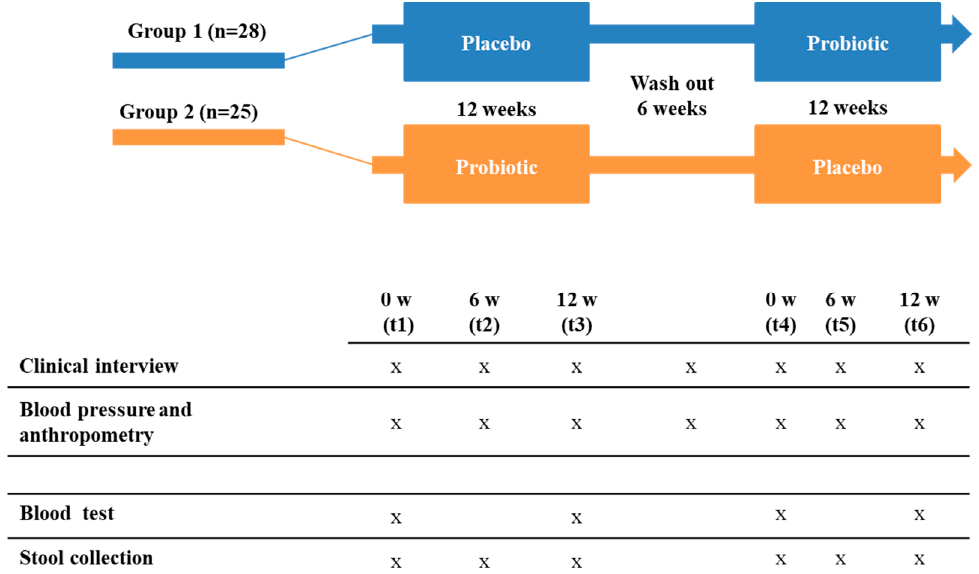
Figure 1. Illustration of the experimental design: A randomized, double-blind, crossover, placebo- controlled, single-center trial comparing the effect of consumption of Lactobacillus reuteri V3401 for 12 weeks on various clinical, biochemical, and inflammatory biomarkers and gastrointestinal microbiota. w: weeks; t: time; x: sample collection.